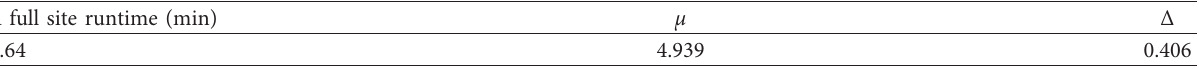
Figure 5: Line travel time fit diagram for the study period. Table 4: Line travel time fitting parameters during the study period.